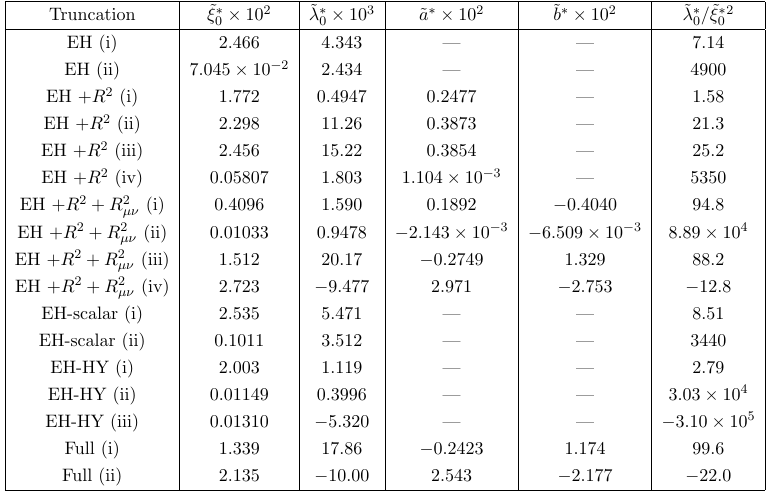
Table 5 . The values of (cid:12)xed points for (cid:11) = 0 and (cid:12) = (cid:0) 1.